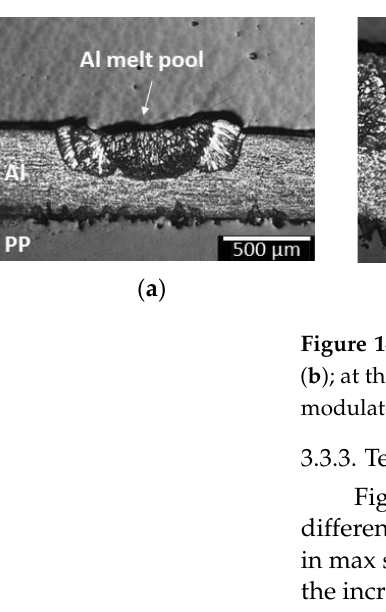
Figure 13. Different cross sections of defects: hole ( a ); bubble ( b ); lack of wettability or unreachable cavities ( c ); and an open hole in Al due to excessive thermal decomposition of PP ( d ).